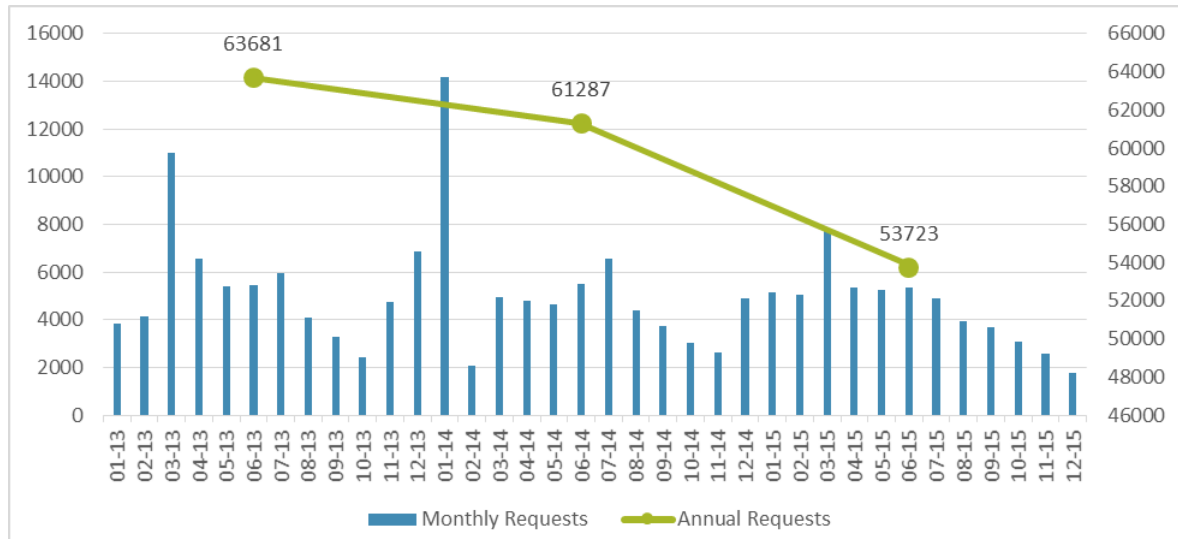
Figure 3. Total number of requests by month (From January 2013 to December 2015).